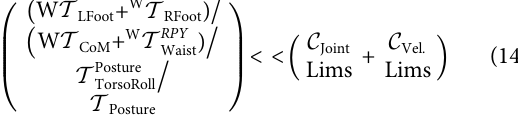
Frontiers in Robotics and AI |